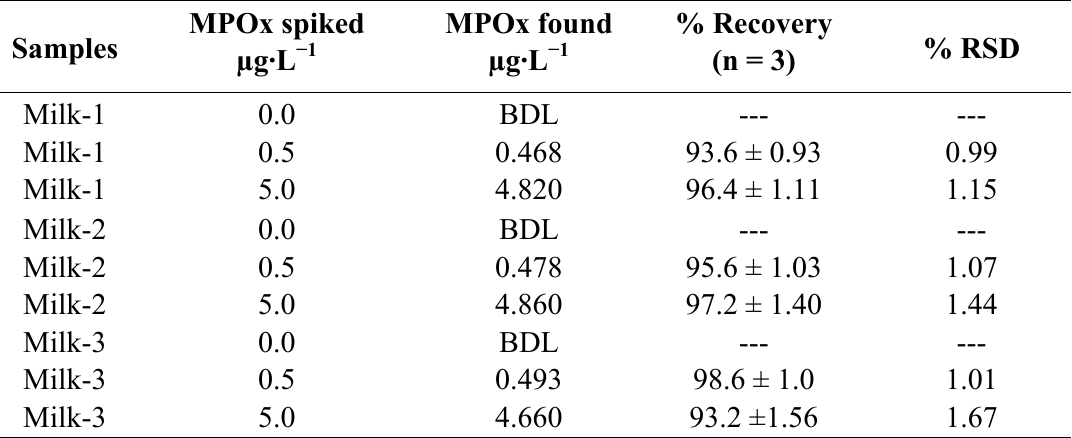
Table 3. Analysis of MPOx in real milk samples and recovery